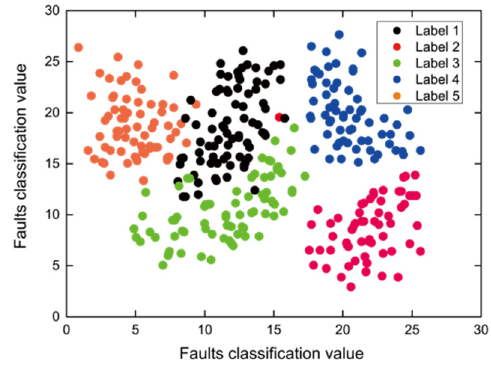
Figure 20. Feature visualization through t ‐ SNE.